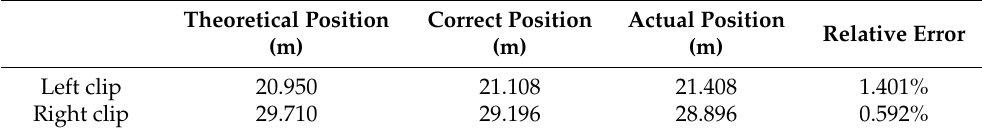
Figure 14. Correction diagram of two-span mid-point anchor clip position. Table 1. Results of the position of the mid-point anchor clip.